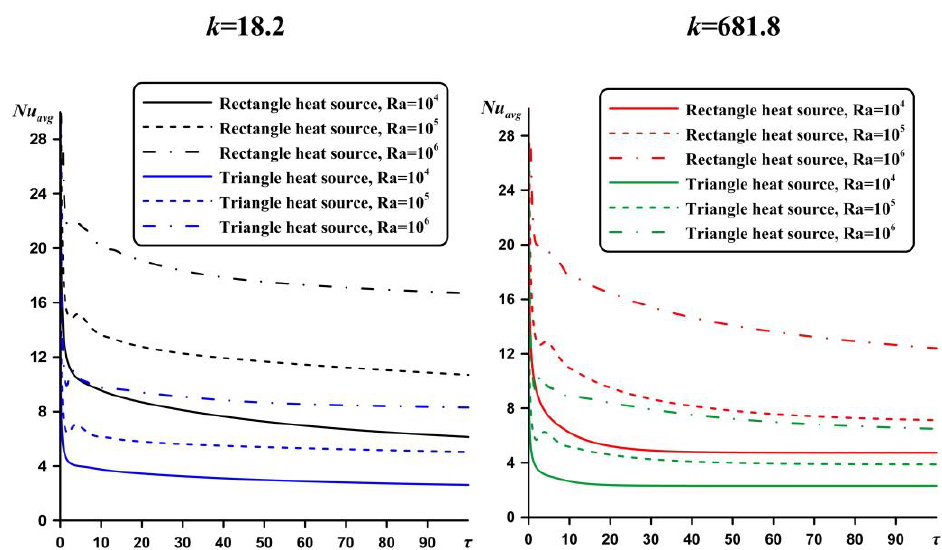
Figure 9. Time profiles of the average Nusselt number at the heater surface depending on the heat source shape, k and Ra .